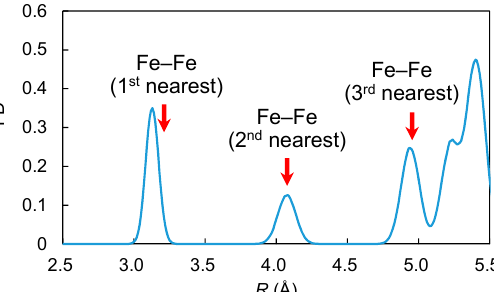
Figure 5. Frequency distribution of Al atoms around Al in γ -LiAlO 2 :Fe 3+ . The arrows indicate the Fe–Fe distances observed in the relaxed structures after MD.